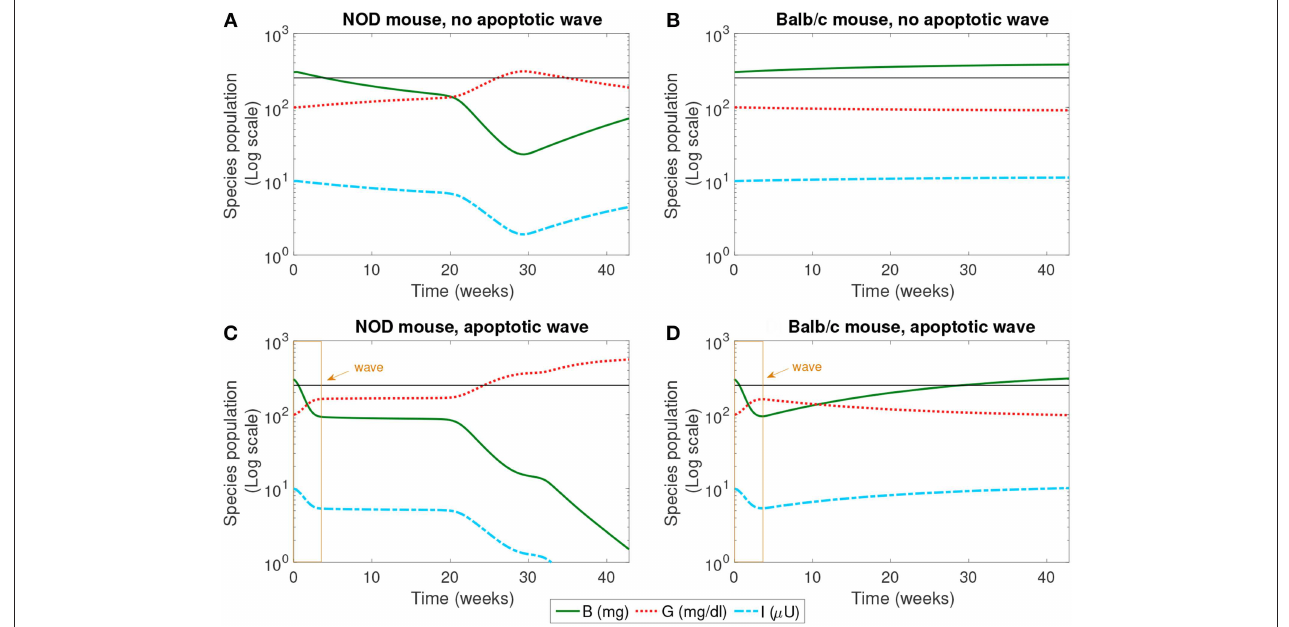
FIGURE 2 | The populations of healthy β -cells ( B ), glucose ( G ), and insulin ( I ) simulated for 40 weeks, according to the mathematical model. We compare the system in the presence and absence of an early wave of apoptosis, and between NOD and Balb/c mice. Multiple glucose readings above 250 mg/dl (shown by the horizontal line) indicate the progression of T1D. The only system that crosses this threshold is the NOD mouse in the presence of the apoptotic wave (C) . (A) NOD mouse, no apoptotic wave, (B) Balb/c mouse, no apoptotic wave, (C) NOD mouse, apoptotic wave, and (D) Balb/c mouse, apoptotic